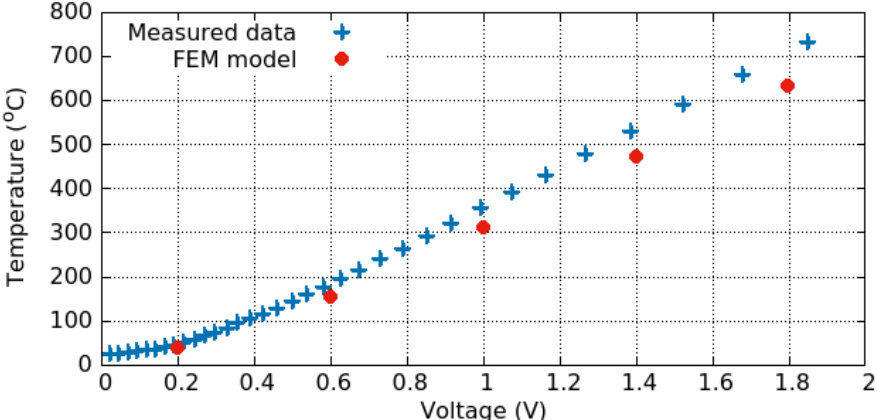
Figure 8. Temperature obtained using an FEM model compared with one calculated using the measured